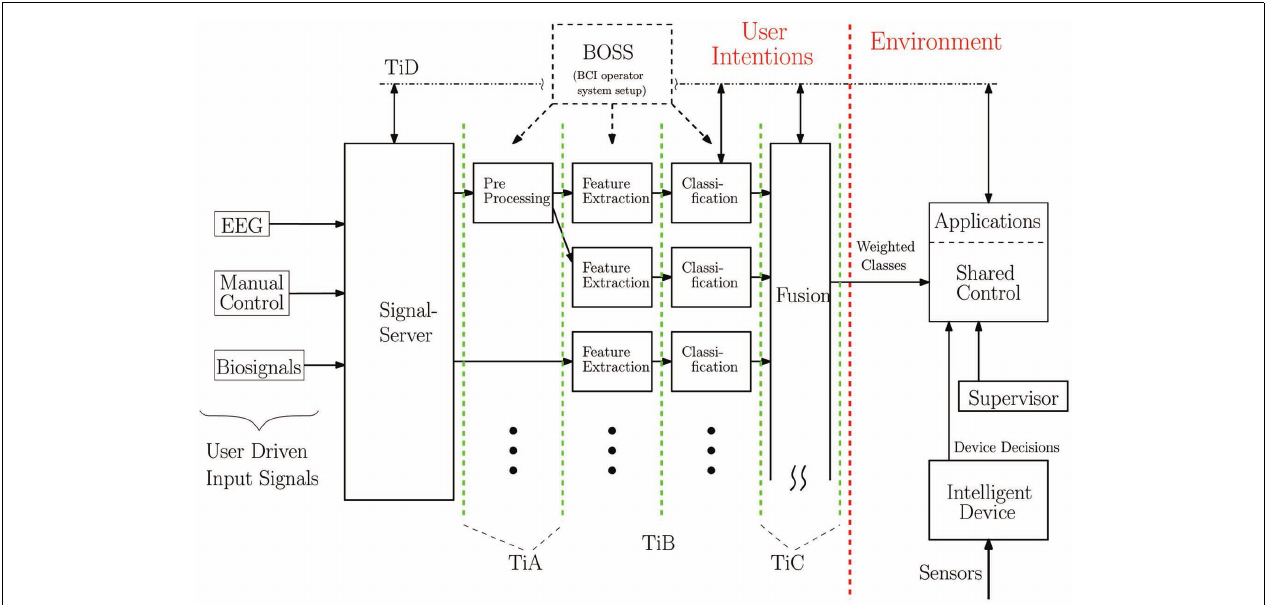
the application receives control commands.The application itself is equipped with sensors and intelligence so that the user environment can support the user’s control signal.ViaTiD events and messages can be sent back to the SignalServer to keep information from, e.g., classifiers within the processing pipeline. A BCI operator system setup (BOSS) module will help with configuration and starting different modules. A supervisor always has the possibility to overrule decisions and perform necessary